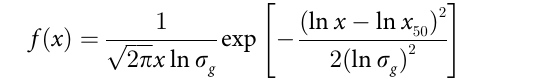
PLOS ONE | https://doi.org/10.1371/journal.pone.0221330 September 6,